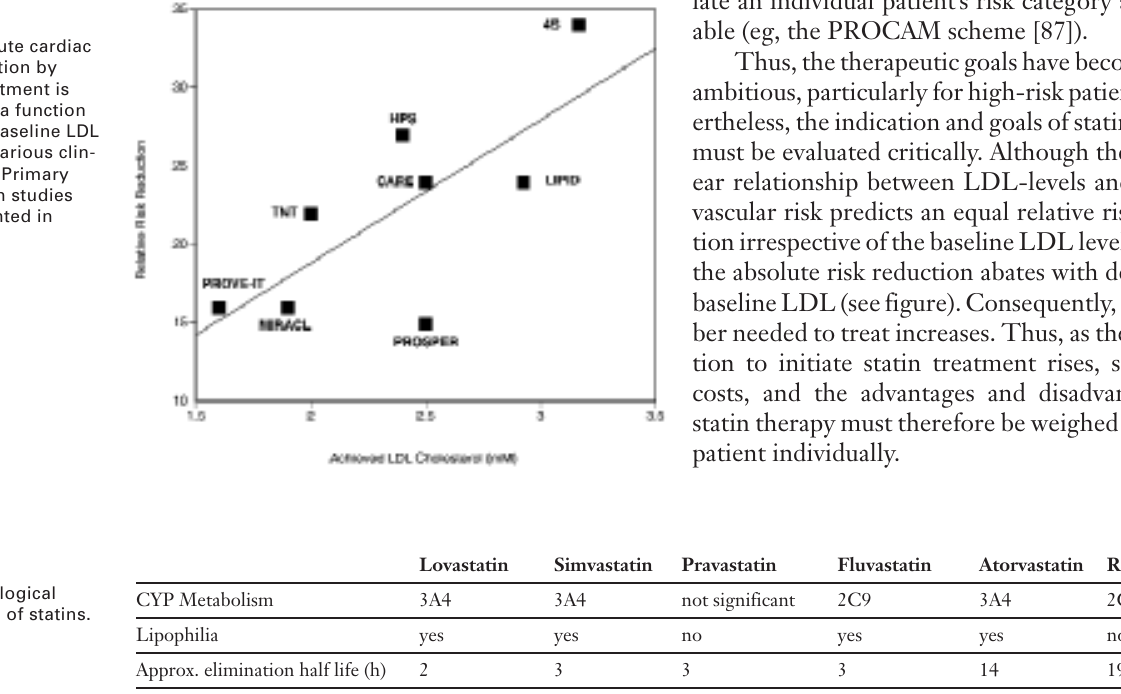
The absolute cardiac risk reduction by statin treatment is shown as a function of mean baseline LDL levels in various clin- ical trials. Primary prevention studies are presented in italics